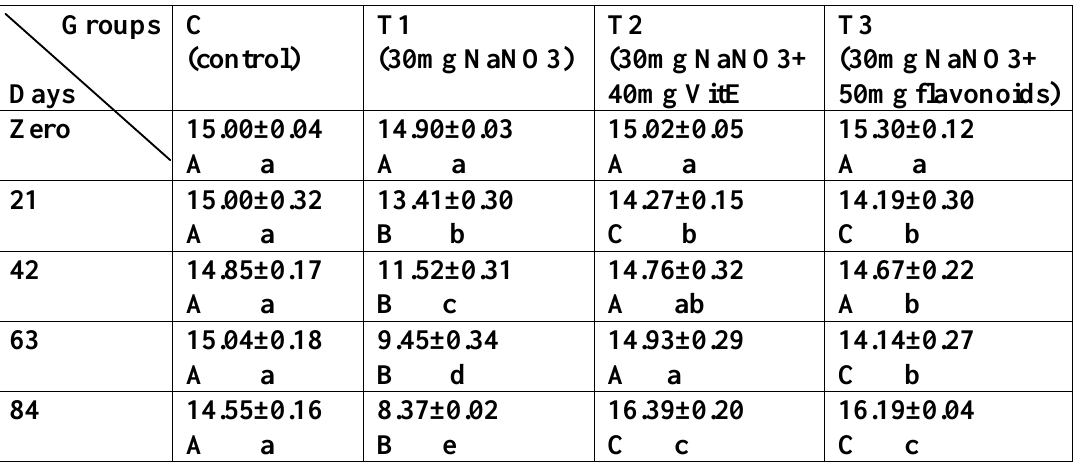
Table (1):Effect of sodium nitrate , vitamin E and flavonoids extracted from Nigella Sativa on hemoglobin concenteration(g/dL) in male